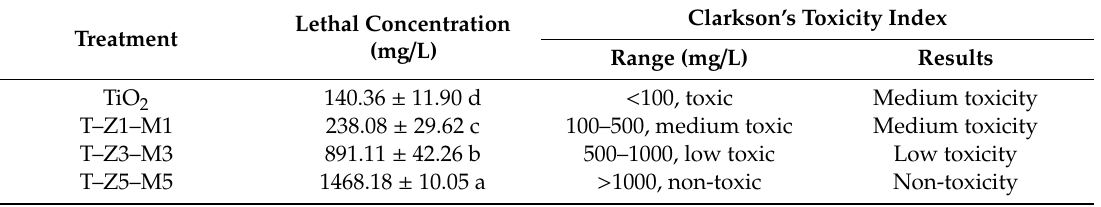
Table 3. Lethal concentration (LC 50 ) values and toxicity index (Clarkson´s index) of TiO 2 and MONs on A. salina